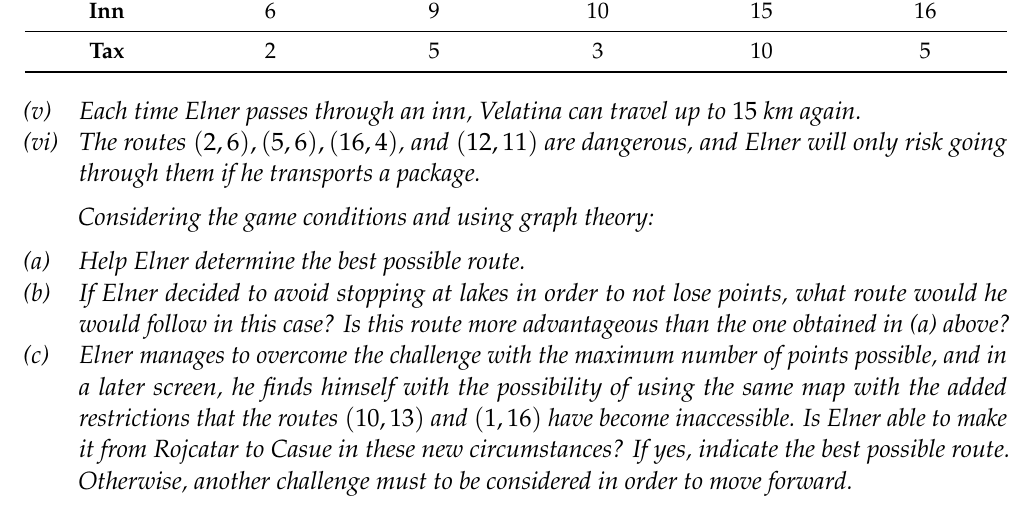
Table 2. Tax in points for passing through each feudal lord’s lands.